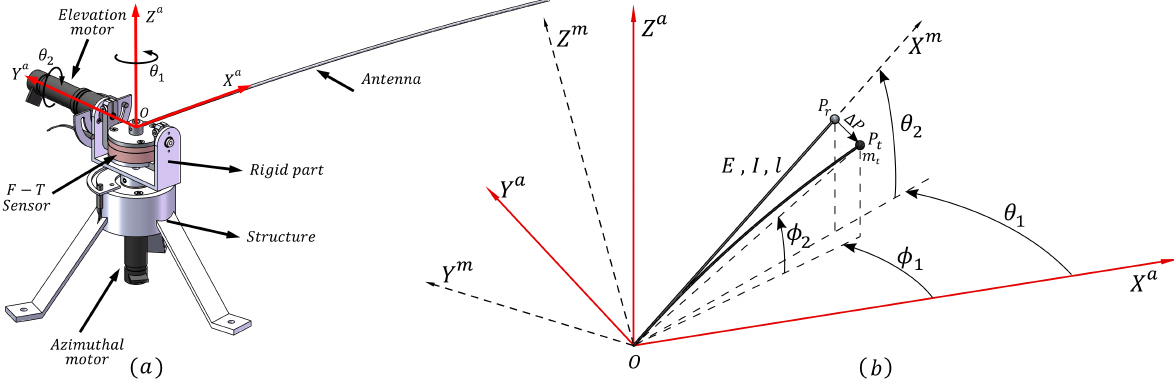
Figure 2. 2DOF flexible-beam sensor: ( a ) mechanism design and ( b ) schematic diagram. F-T, torque-force. A third frame, X c Y c Z c , is defined from the force measured by the F-T sensor at the point at which the antenna touches the surface of an obstacle at a certain point of the antenna at a determined instant: (1) the Y c axis is the direction of the reaction force of the object on the antenna; (2) the Z c axis is perpendicular to Y c and to the vector (cid:126) OP r (see Figure 2b); and (3) the X c axis is perpendicular to the other two axes. Figure 3 shows all the frames and the relations among them.